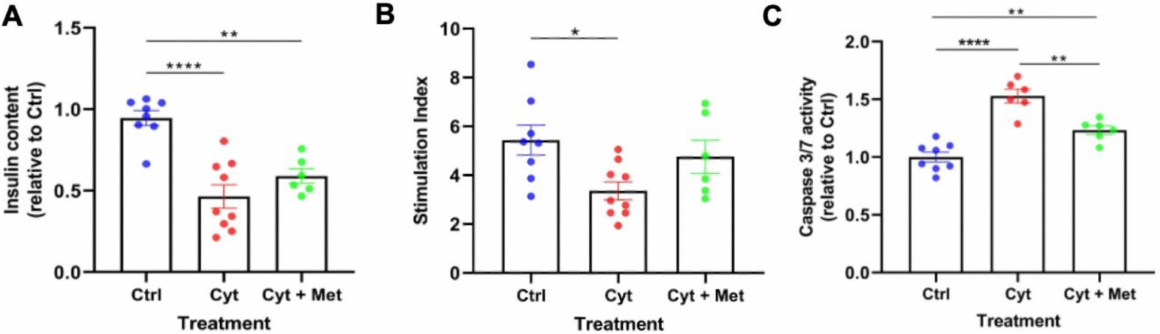
Figure 1. Effect of metformin on cytokine-induced β -cell damage. ( A ) Insulin content, reduced after cytokine-treatment, was marginally affected by metformin. ( B ) Insulin stimulation index was reduced after 48 h treatment with cytokines (Cyt) and tended to return to the control values (Ctrl) in islets treated with metformin (Cyt + Met). ( C ) Cytokines induced a significant activation of caspase 3/7, while metformin significantly reduced this activation. One to three replicates from three to four independent islet preparations were studied. The different groups were compared with One-way ANOVA followed by the Tukey correction. **** p < 0.0001, ** p < 0.01, * p <